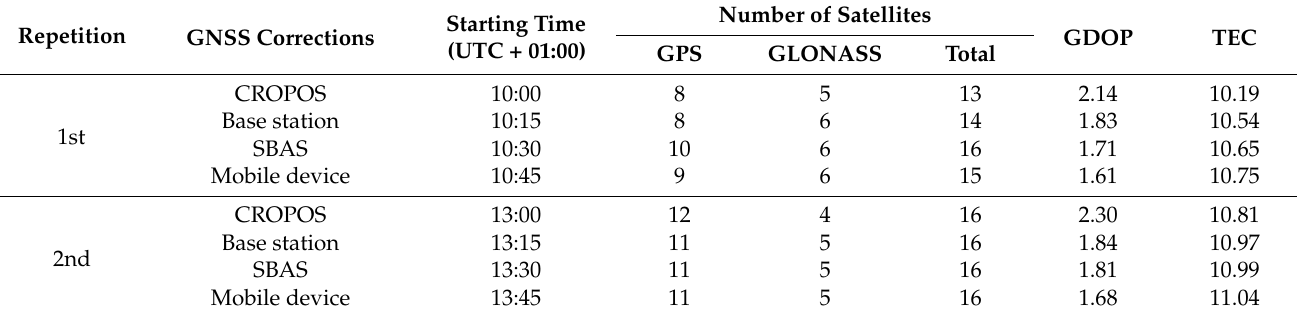
Table 1. Start time periods and GDOP for the used RTK corrections in two repetitions according to Trimble GNSS Planning